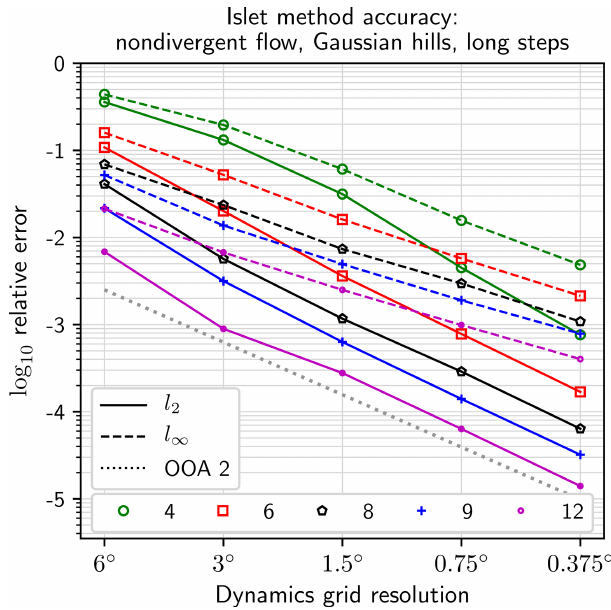
Figure 4. Accuracy diagnostic. Compare with Figs. 1 and 2 in